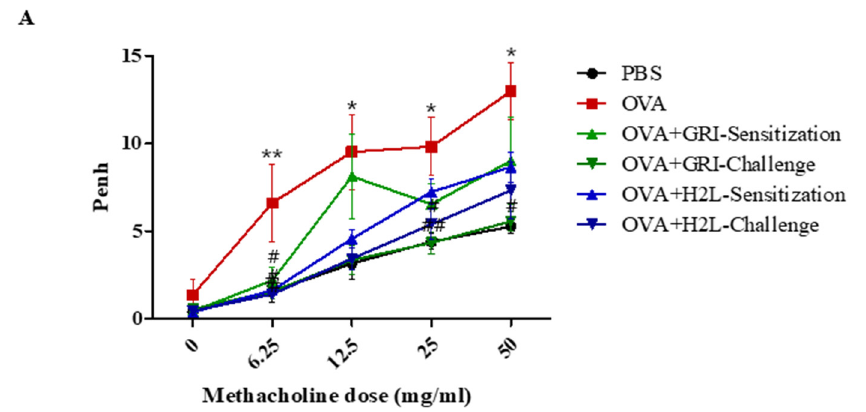
Figure 3. H2L5186303 and GRI977143 suppressed OVA-induced airway hyper responsiveness. The effects of H2L5186303 and GRI977143 on AHR were measured using noninvasive whole-body plethysmography. Values are presented as the mean ± SEM of three independent experiments. # p < 0.05, ## p < 0.01 vs. control group; * p < 0.05, ** p < 0.01 vs. OVA group.